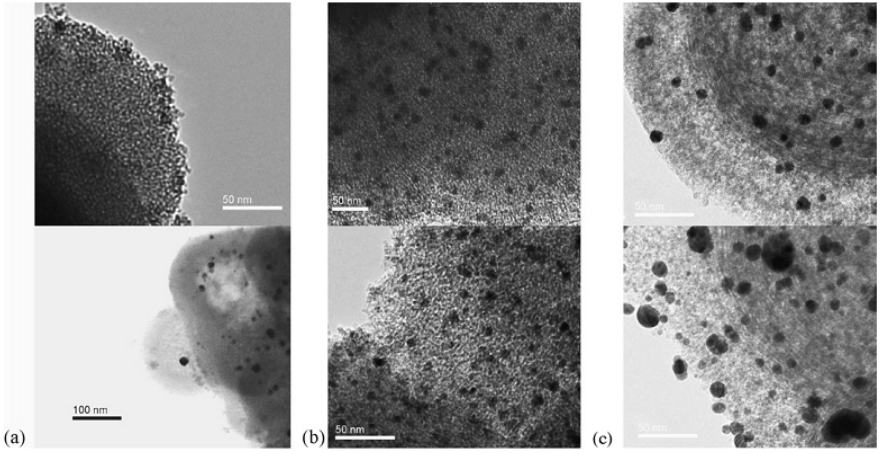
Figure 10. TEM images of ( a ) Au/Ti-HMS ( in situ ); ( b ) Au/Ti-HMS (NH ( c ) Au/Ti-HMS (urea Dp). Reproduced with permission from [40]. Copyright 2010 Elsevier